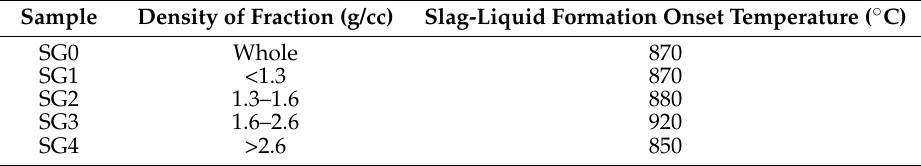
Table 4. Temperature of slag-liquid formation onset for each gravity fraction and whole coal (Thermo-mechanical analysis (TMA) results).